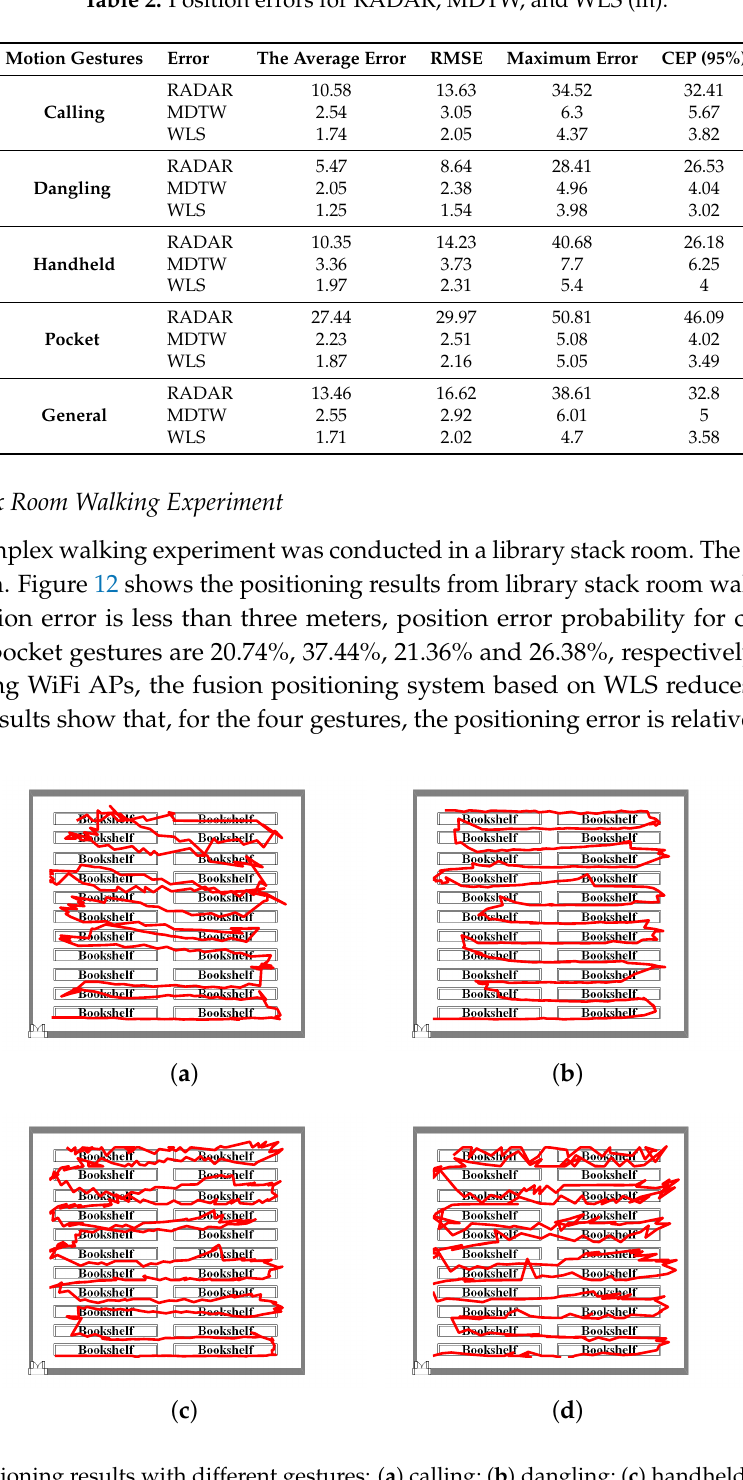
Figure 12. Positioning results with different gestures: ( a ) calling; ( b ) dangling; ( c ) handheld; and ( d )